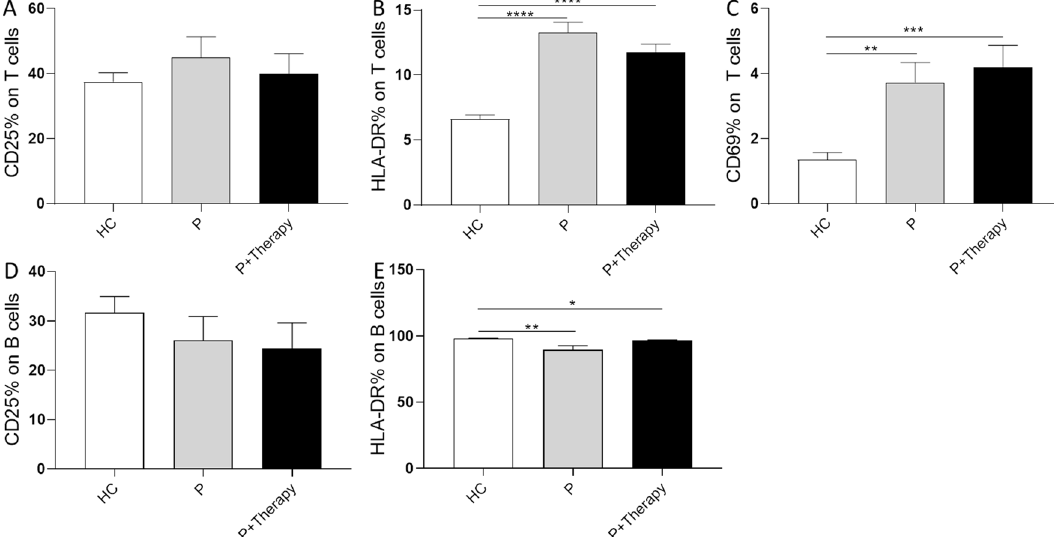
Figure 2. Analysis of activation markers on subsets of peripheral blood cells. The activation markers CD25, CD69 and HLA-DR were analysed for their expression on peripheral blood cell subtypes T cells and B cells in healthy controls (HC) and patient blood before their first (P) and after second therapy treatment (P + Therapy). ( A ) CD25 on T cells is slightly downregulated in OA patients after second treatment. ( B ) The percentage of HLA-DR on B cells is slightly upregulated in OA patients compared with healthy controls after treatment. ( C ) CD69 on T cells shows an increase in OA patients after therapy treatment. Overall, this activation marker is are given as mean ± SEM; T-test, *p < 0.5; **p < 0.01; ***p < 0.001; ****p <